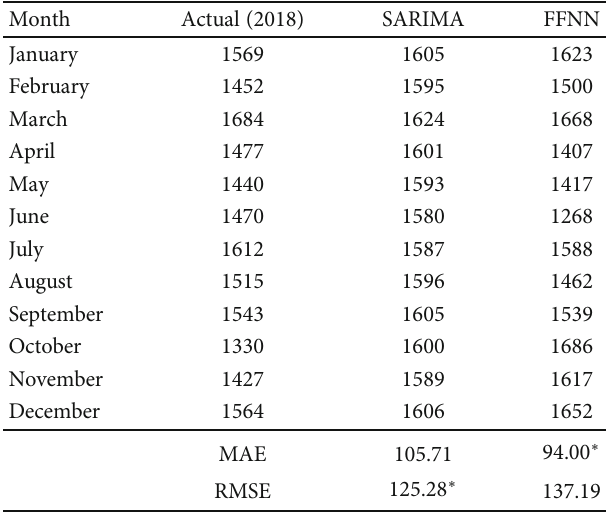
Table 5: Forecasts of ambulance demand by the FFNN and SARIMA models.